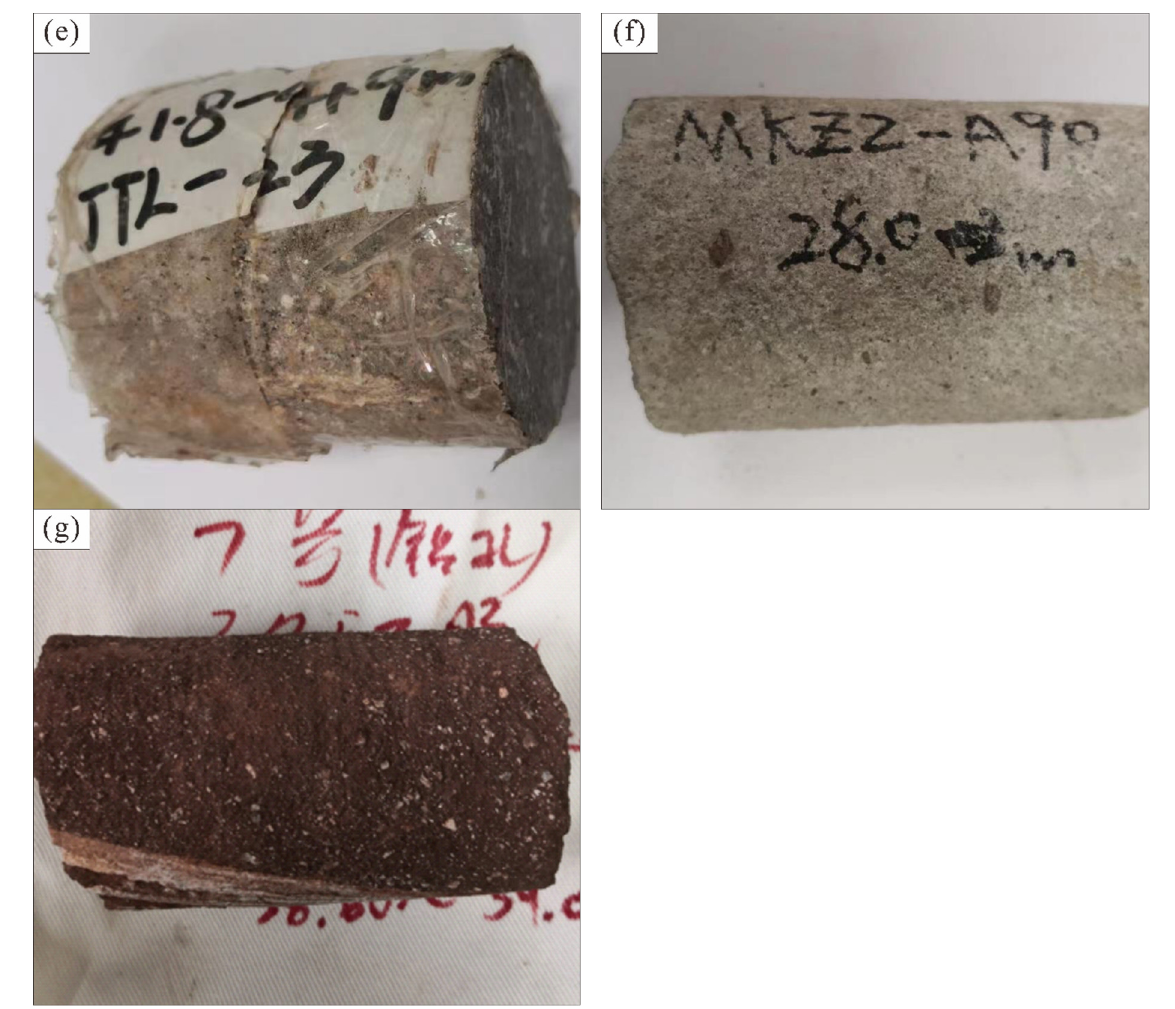
Figure A2. Photos of samples in this study. ( a ) sample #2; ( b ) sample #1; ( c ) sample #4; ( d ) sample #3; ( e ) sample TTL-23; ( f ) sample MKZ2-A90; ( g ) sample #7.